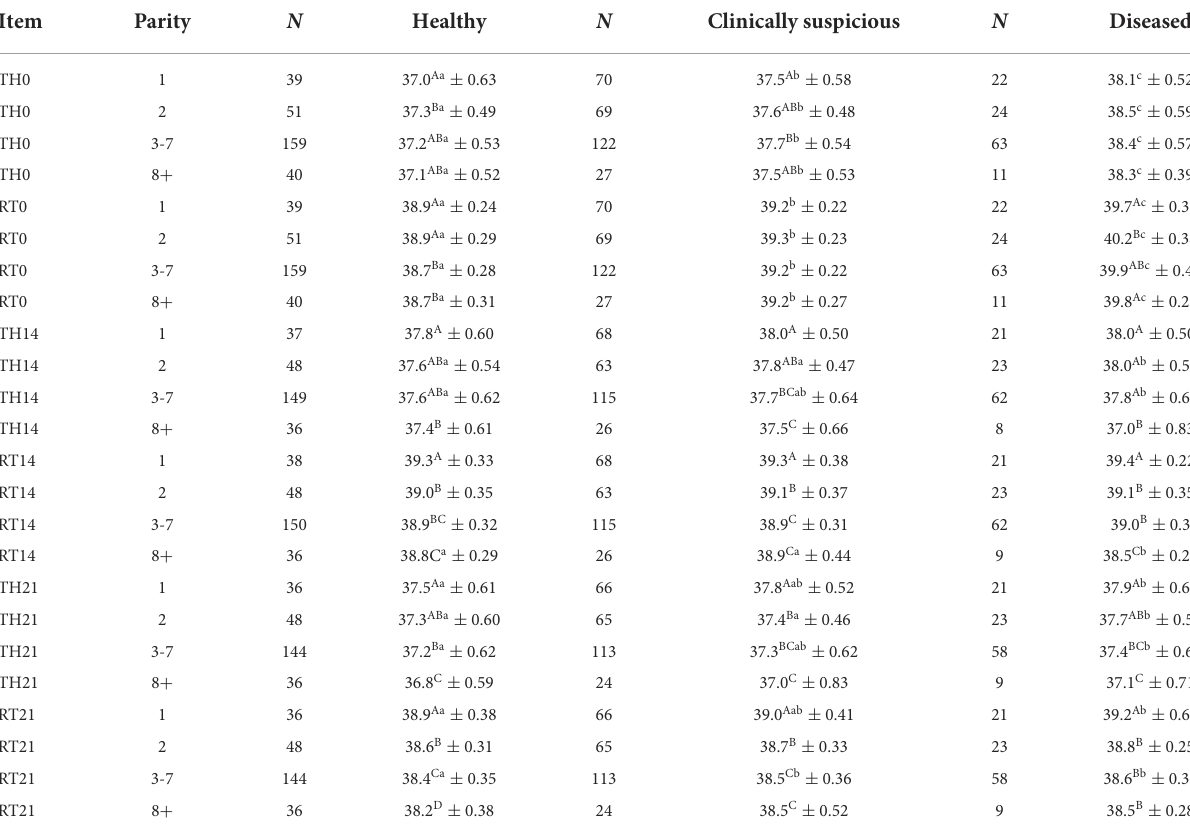
TABLE 2 Thermographic skin temperature and rectal temperature ( ◦ C) compared between healthy, clinically suspicious and diseased sows of different parities.